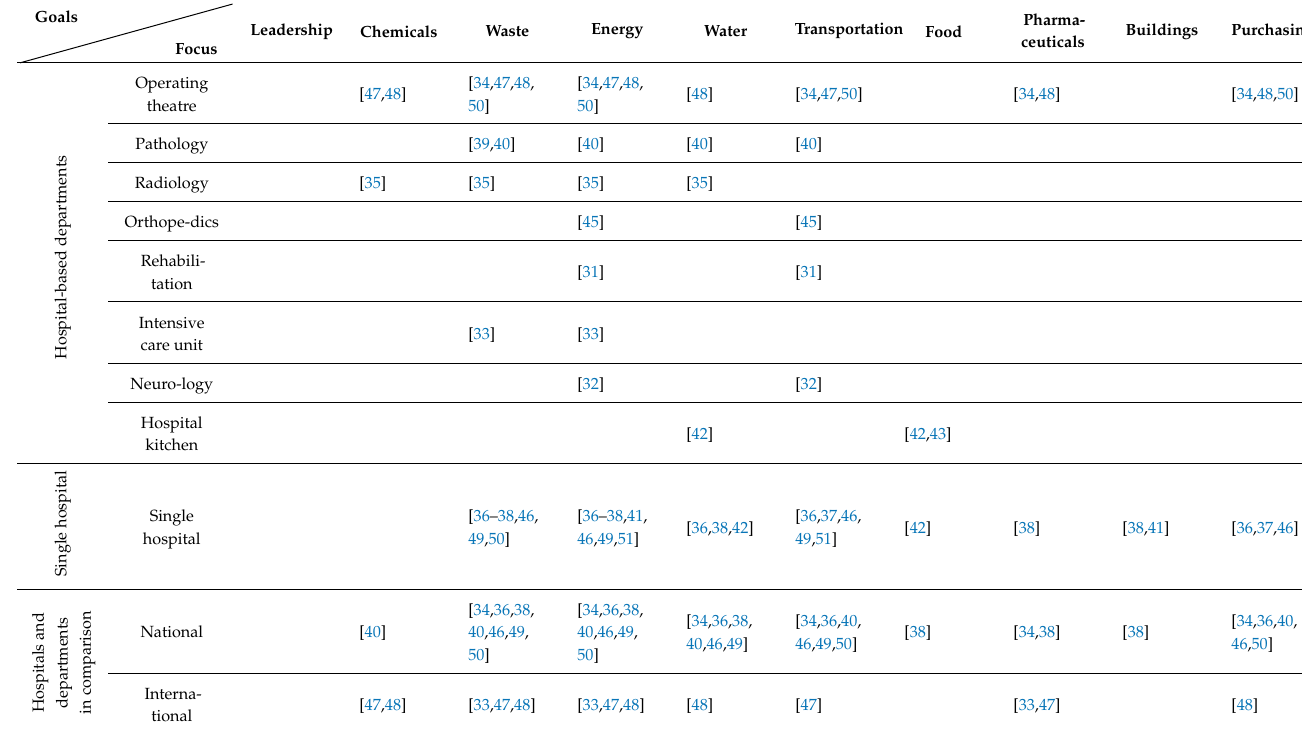
Table 3. Matrix of Sustainability Goals (GGHH) and hospitals’